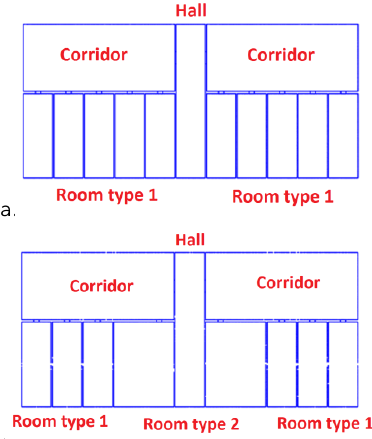
Figure 5. Building floorplan for Floor 1 (a) and Floor 2 (b).